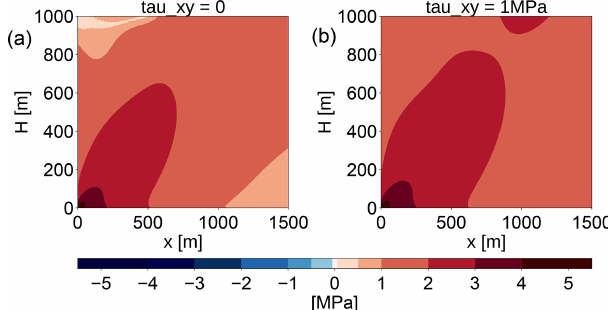
Figure 9. Maximum shear stress τ max in the vicinity of the calving front in the case without lateral drag (a) and with a constant lateral drag of τ xy = 1MPa (b)